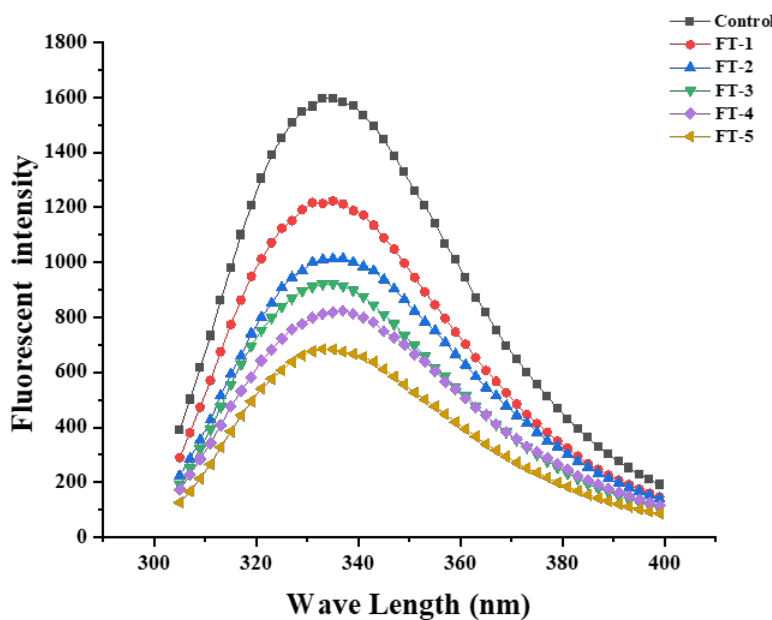
Figure 7. Intrinsic fluorescence emission spectra of MP of cuttlefish after freeze–thaw cycles.